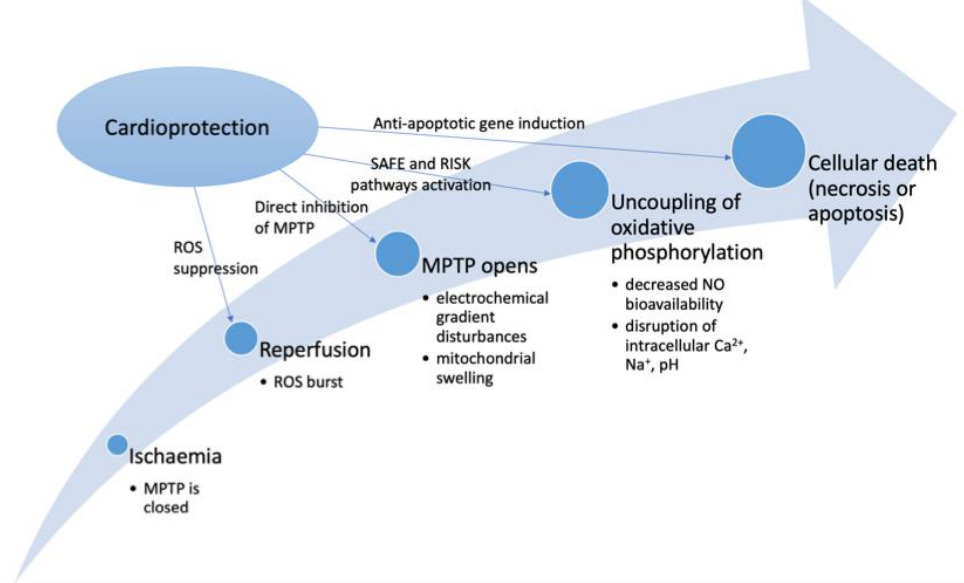
Figure 1. Summary of mechanisms of ischaemia reperfusion and cardioprotection. Legend: ROS —